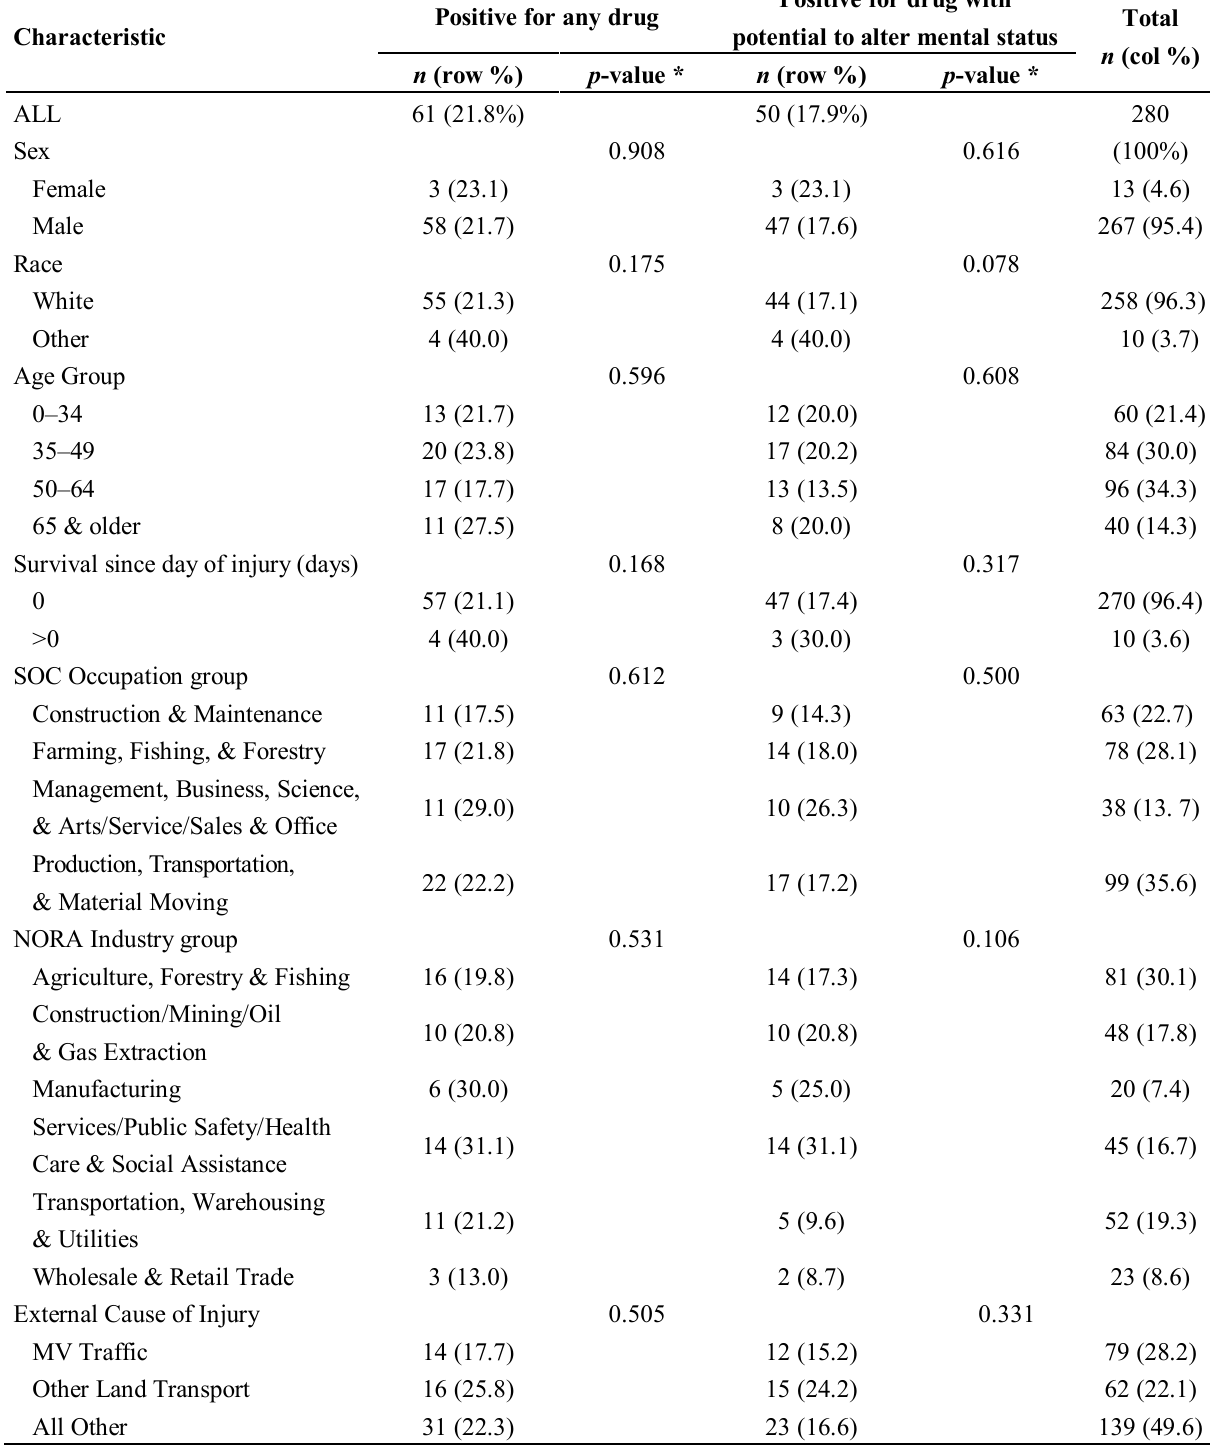
Table 3. Demographic, occupation, and industry characteristics by toxicology testing results for IA worker fatalities ( n =